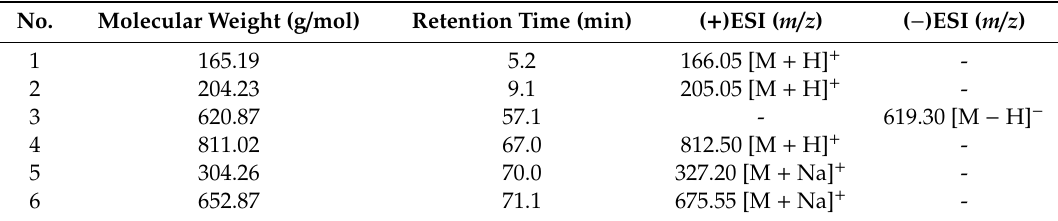
Table 1. Mass data of identified compounds in Momordica charantia L. and Momordica charantia L. var. abbreviata Ser. juice solutions.